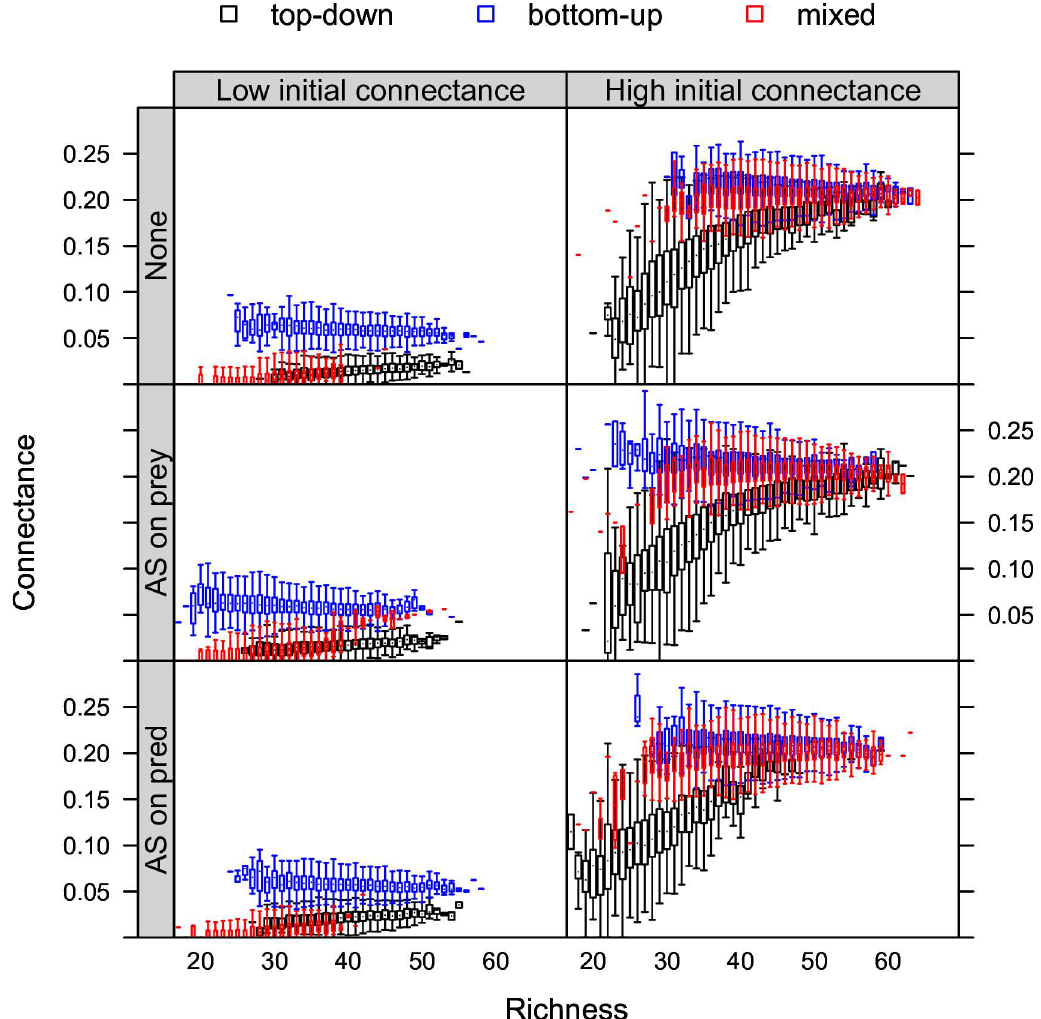
Fig 4. The relationship between connectance and total richness (prey and predators together) under stress. Biotic stress (top-down, bottom-upor mixed control) and abioticstress (none, AS on prey, AS on predators) at low and high initial